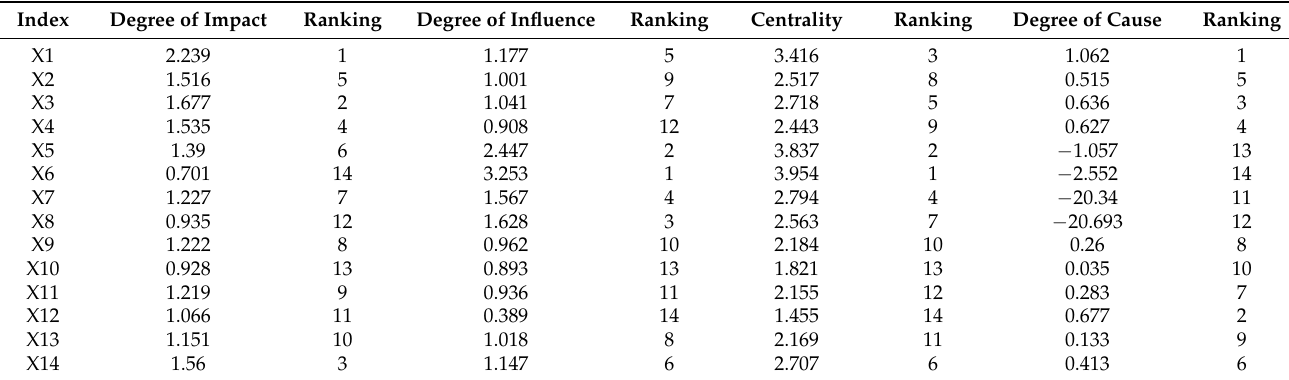
Table 5. DEMATEL model calculation